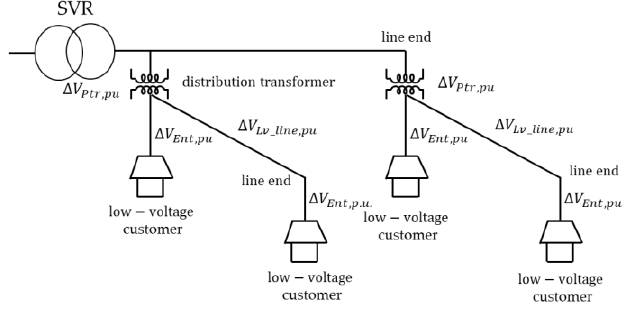
is denoted by (cid:52) V Ptr , pu , the voltage drop of the low-voltage line by (cid:52) V LV _ line , pu , the voltage drop of customer entrance by (cid:52) V Ent , pu , and the primary-side voltage of the distribution transformer by V High , pu . Then the voltage of the low-voltage customer just under the distribution transformer just under the SVR becomes to be V High , pu − (cid:52) V Ptr , pu − (cid:52) V Ent , pu and the voltage of the low-voltage customer at the end of the line after the distribution transformer V High , pu − (cid:52) V Ptr , pu − V LV _ line , pu − (cid:52) V Ent , pu . the line after the distribution transformer 𝑉 𝐻𝑖𝑔ℎ,𝑝𝑢 −△ 𝑉 𝑃𝑡𝑟,𝑝𝑢 − 𝑉 𝐿𝑉_𝑙𝑖𝑛𝑒,𝑝𝑢 − △ 𝑉 𝐸𝑛𝑡,𝑝𝑢 .